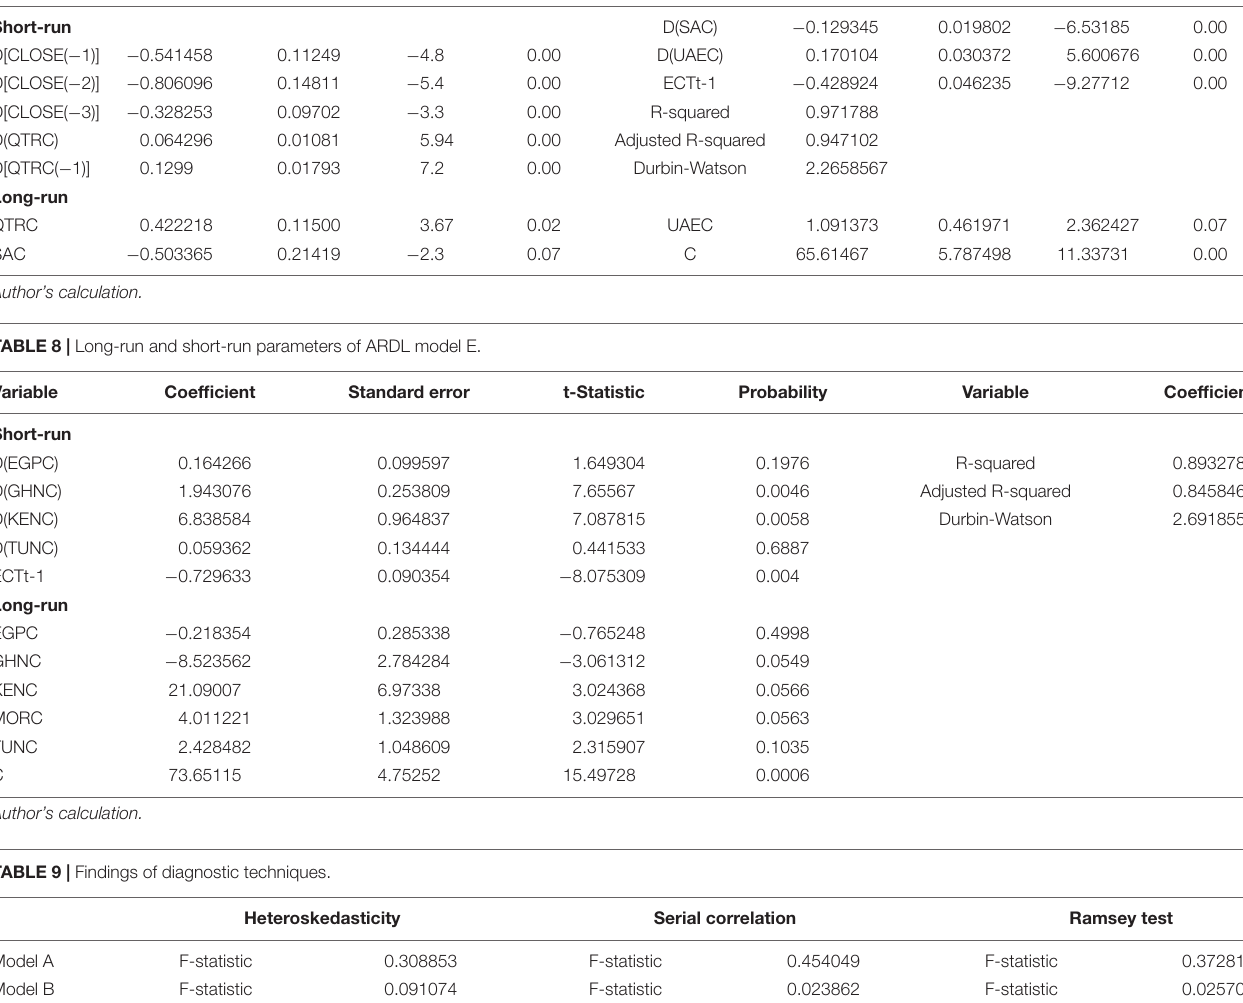
TABLE 7 | Long-run and short-run parameters of ARDL model D. Variable